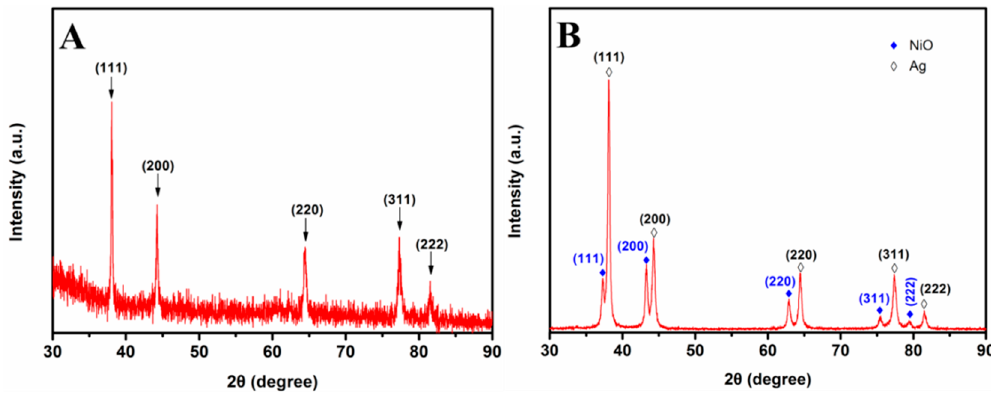
Figure 5. XRD patterns of ( A ) porous Ag and ( B ) Ag-NiO nanofibers, respectively.